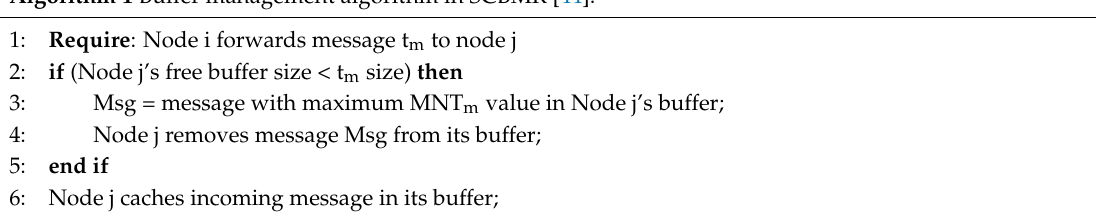
Algorithm 1 Buffer management algorithm in SCBMR